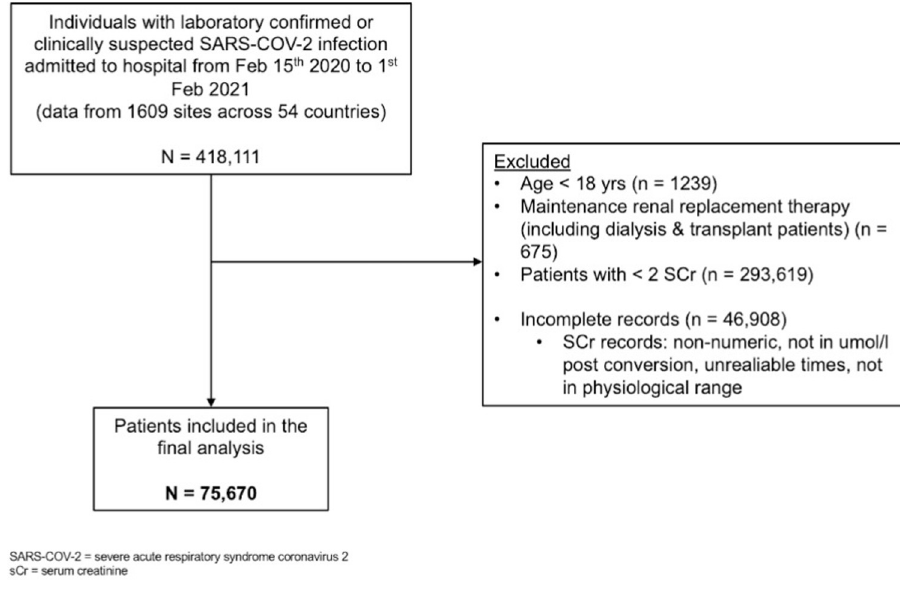
Fig 1. Flowchart of the